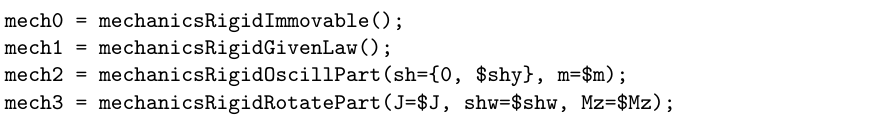
Figure 17. The mechanics file